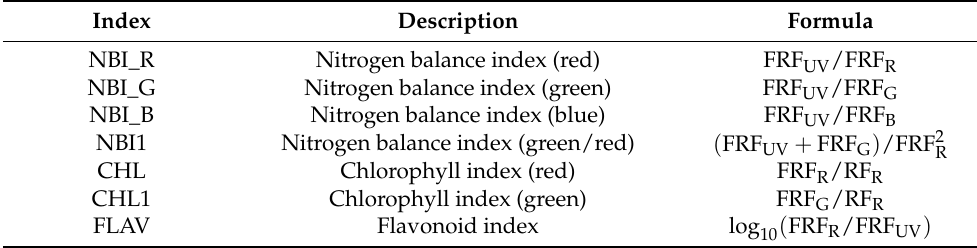
Table 1. Fluorescence-based vegetation indices derived from Multiplex